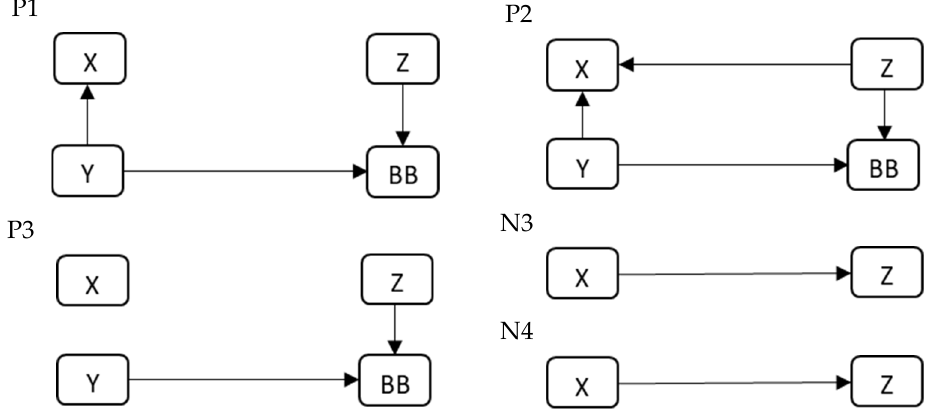
Figure 1. Visualization of significant differences in the answers to statements P1, P2, P3, N3, and N4 given by the respondents from different generations based on the post hoc tests.